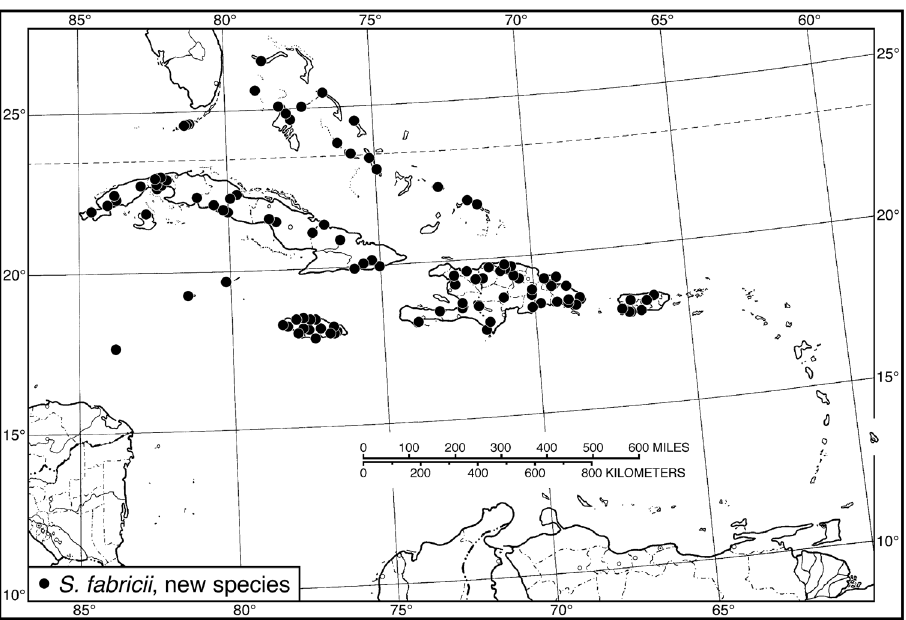
Figure 45. Map of West Indies showing known localities for species of Selenophorus opalinus species group, in